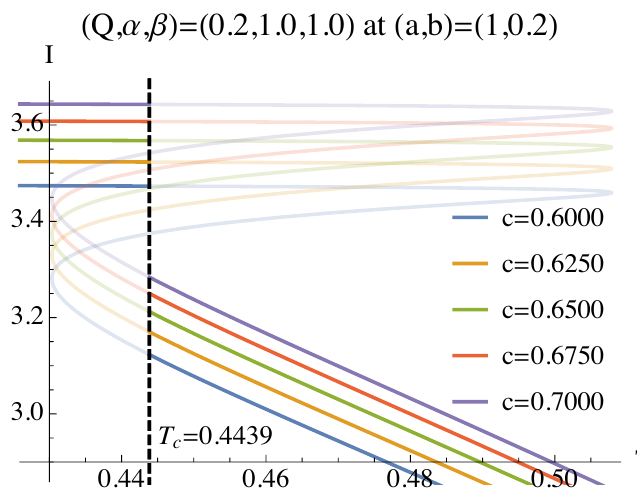
Figure 8 . The T vs. I in the scenario with a first-order phase transition, where the lighter segments correspond to the metastable regions. The red dashed horizontal line represents the critical temperature T c = 0 . 4439 of the first-order phase transition.